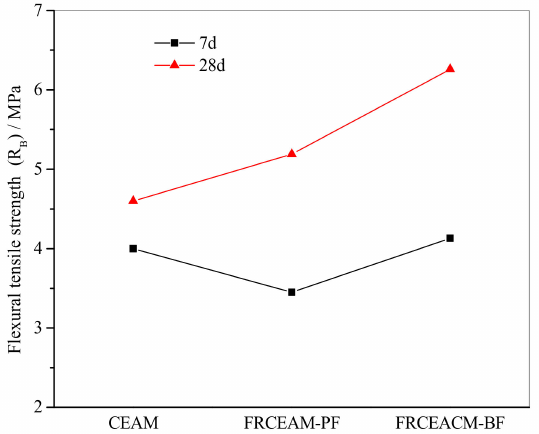
Figure 6. Flexural tensile strengths of CEAM and FRCEAM.